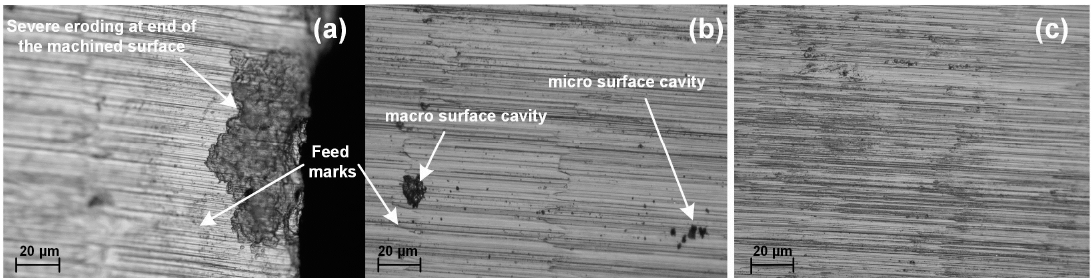
Figure 10. Light microscopic image of the quality of the machined surface: ( a , b ) damage when using the conventional supply system; and ( c ) surface produced using Cut-list (all at 200 m/min and 0.15 mm/rev cutting speed and feed rate respectively).